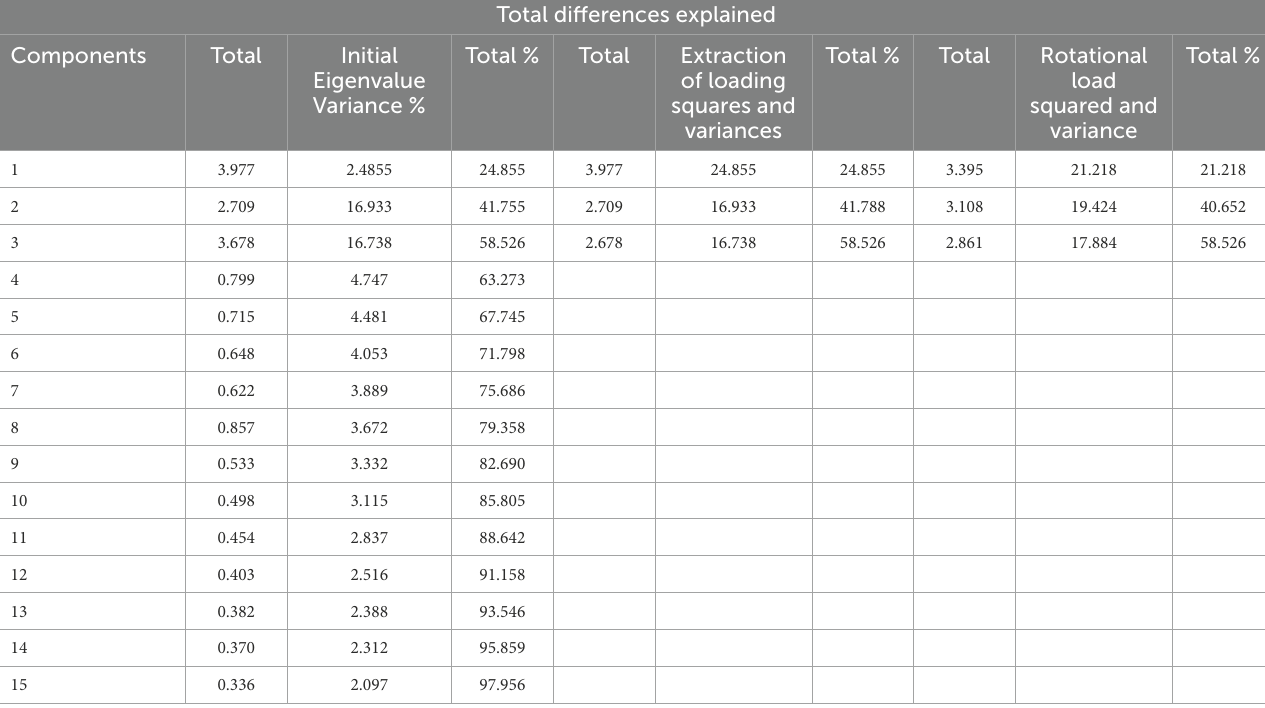
TABLE 6 Factor analysis of the learning needs scale. Components Total Initial